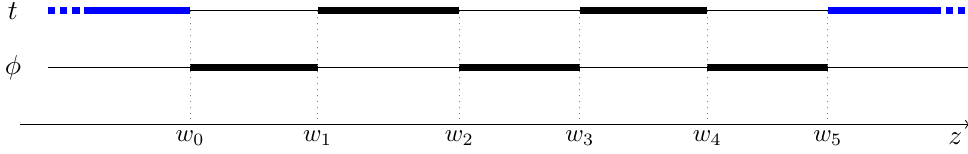
Figure 8 . Rod diagram for a binary black hole system inside a bubble of nothing. The black timelike rods (thick lines of the t coordinate) represent the black hole horizons, while the blue timelike semi-infinite rods correspond to the bubble horizon. This diagram corresponds to the double-Wick rotation of the three-source Israel-Khan solution